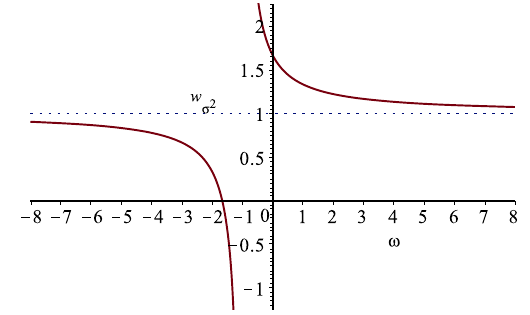
Fig. 1 Effective equation of state parameter corresponding to the expansion anisotropy w σ 2 versus Brans–Dicke parameter ω . w σ 2 exhibits a pole at ω = − 1, and w σ 2 → 1 as | ω | →